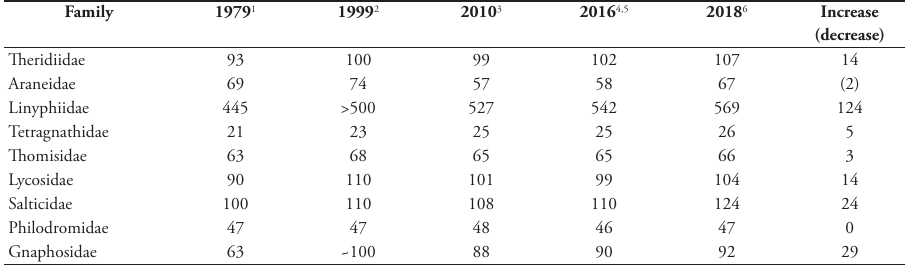
Table 2. Changes in numbers of species for selected spider families in Canada (1979–2018).